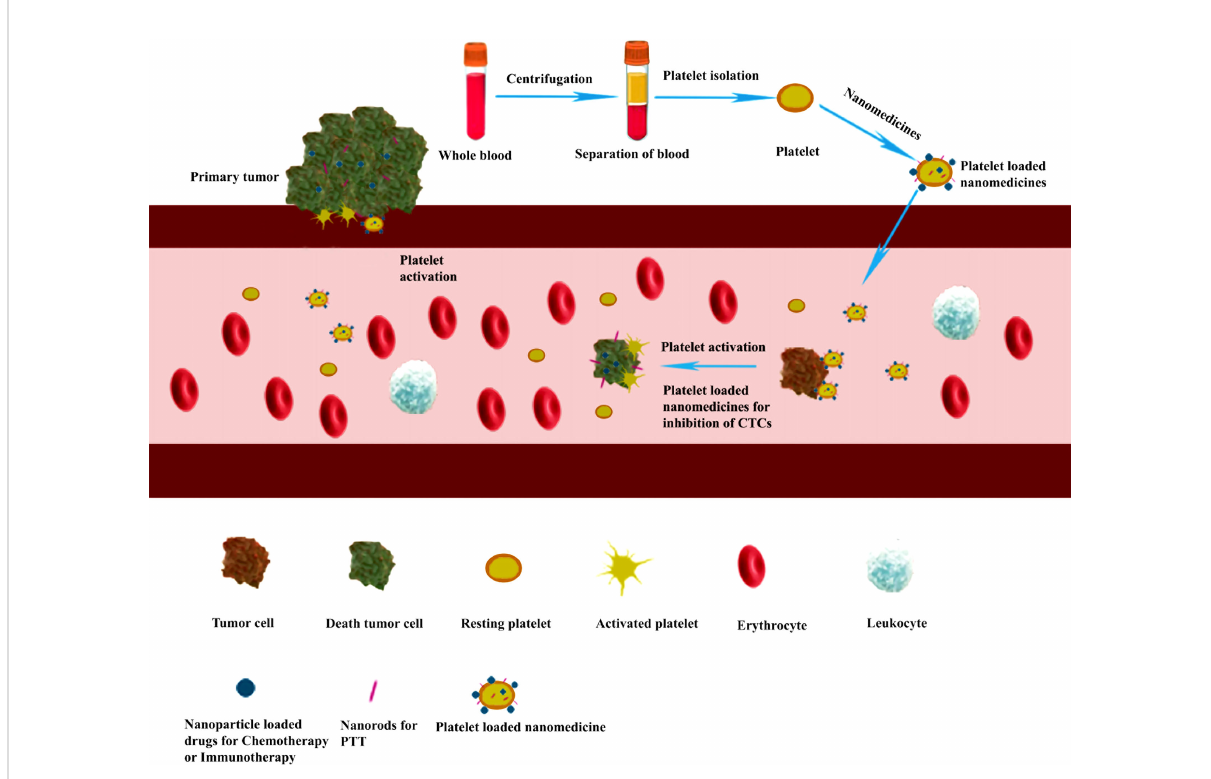
FIGURE 4 Platelet-loaded nanomedicine for inhibiting tumor growth and metastasis through chemotherapy, immunotherapy, or photothermal tumor therapy (PTT). Puri fi ed platelets were obtained from the whole blood by centrifugation. Then the nanomedicines were loaded into the platelet through electroporation methods to form a platelet-loaded nanomedicine system. After intravenous injection, the platelet-loaded nanomedicines would interact with tumor cells through adhesion and activation, and the loaded medicines are released for inhibiting tumor growth and metastasis through chemotherapy, immunotherapy, or